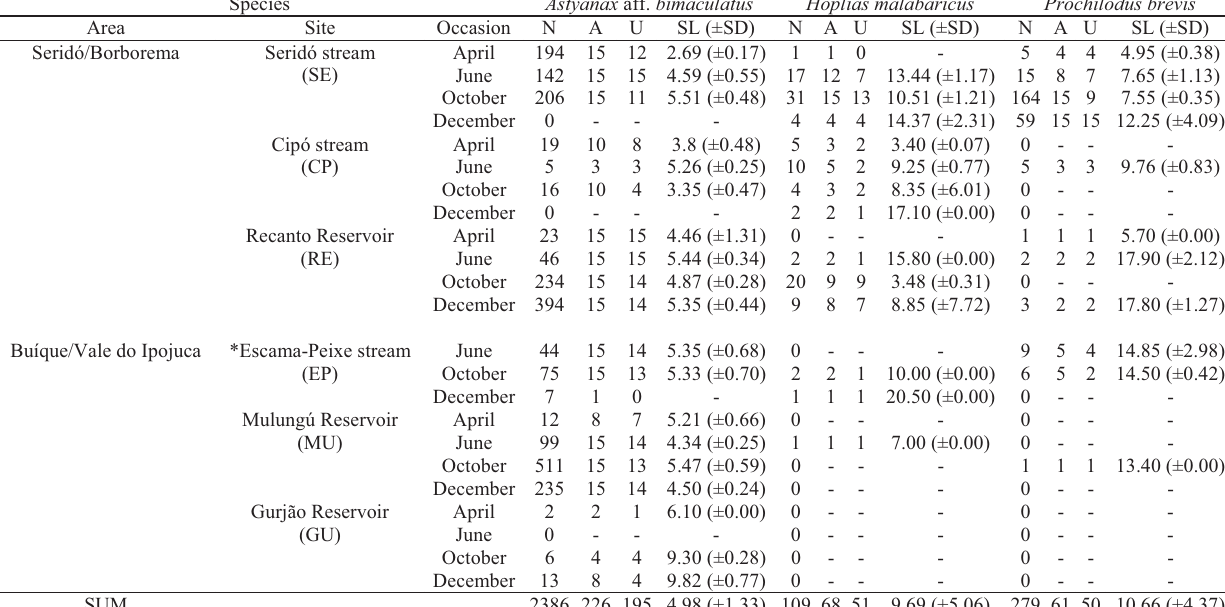
Table 1. Total number of fish caught (N), number of stomachs analyzed (A) and number of stomachs used (U) (>20% fullness) of each species in six sites located in the Brazilian semi-arid region. Fish sizes (Standard length - SL) are expressed as mean ± SD. * not sampled in April